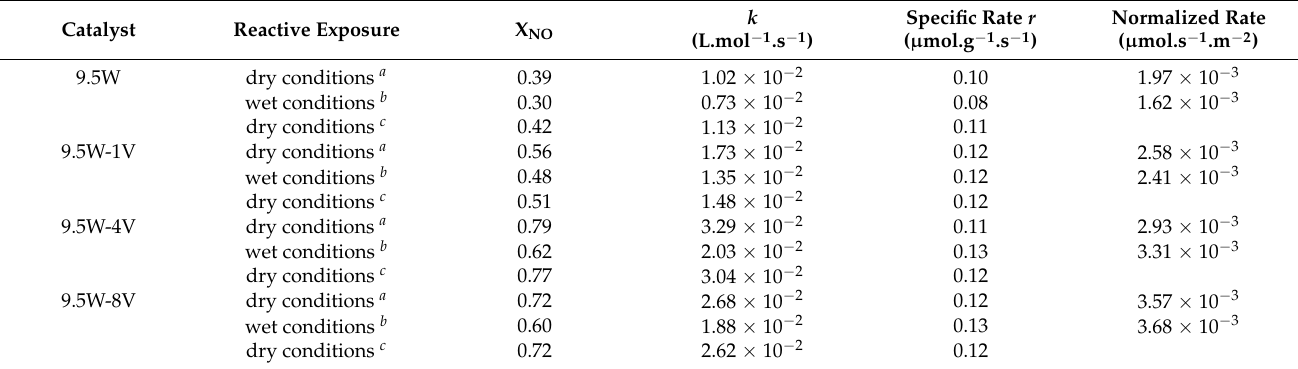
Table 4. Rate measurements during ammonia-SCR on 9.5W- x V catalyst at 160 ◦ C.